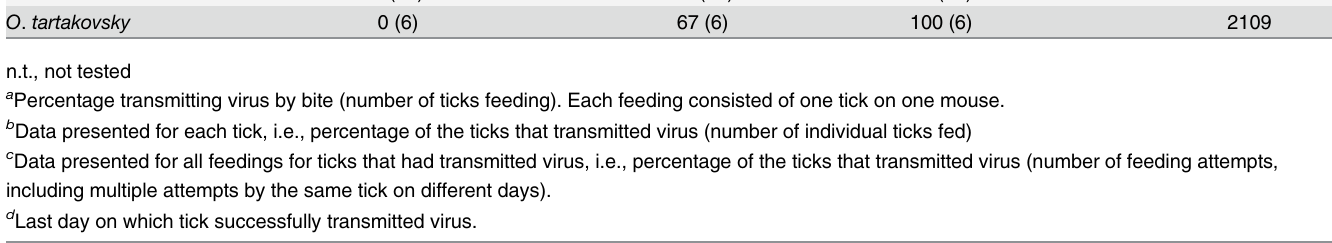
including multiple attempts by the same tick on different days). d